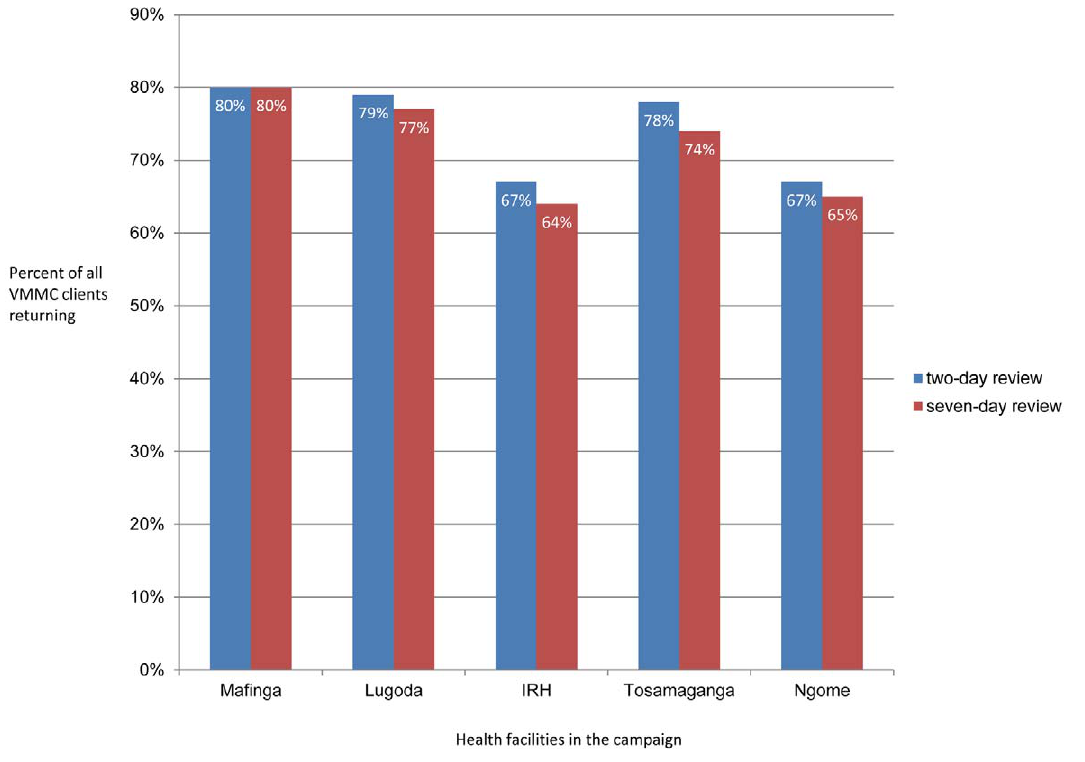
Figure 3. Postoperative return rates two and seven days after surgery. doi:10.1371/journal.pmed.1001131.g003 PLoS Medicine |